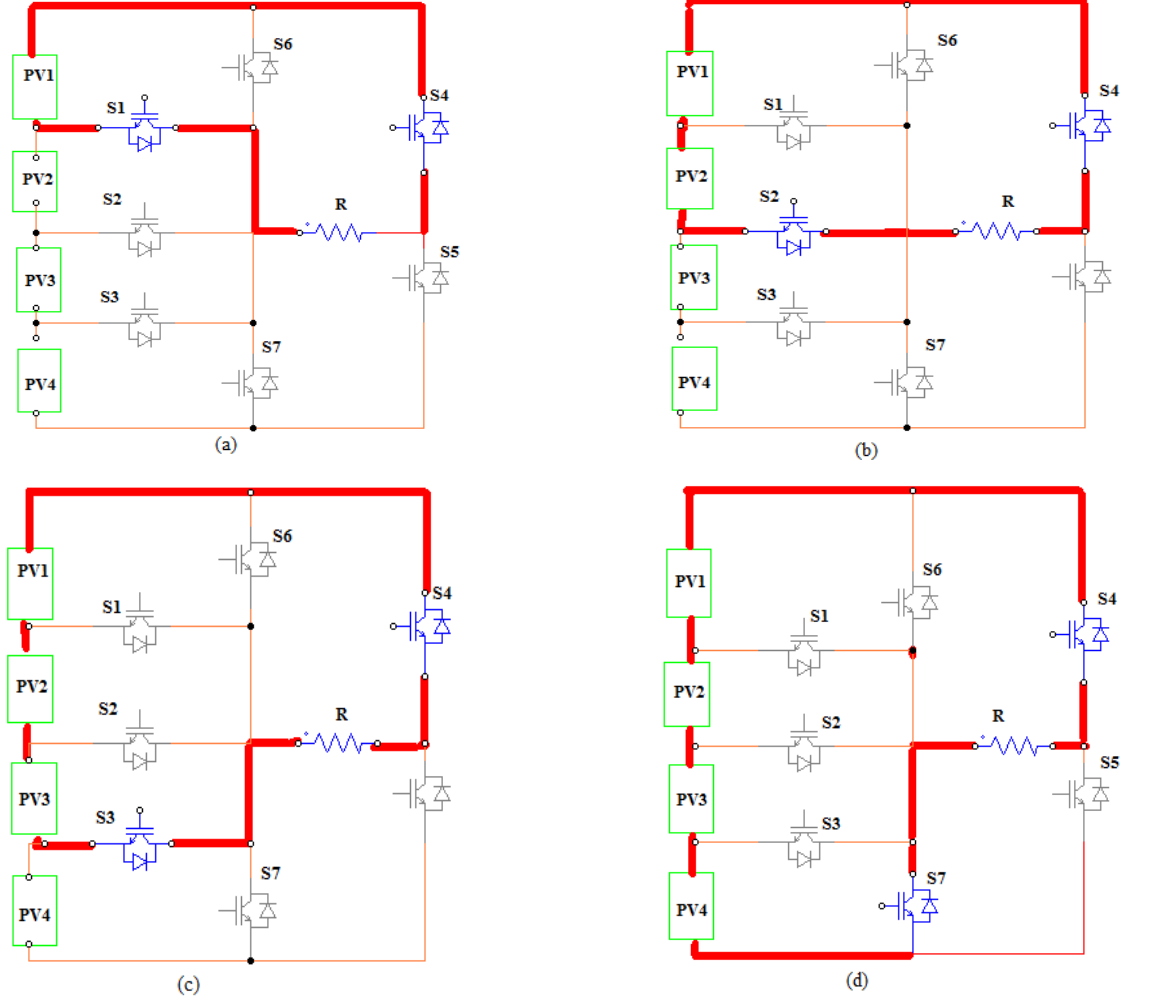
Figure 18 . Negative sequences for synthesizing the nine-level output voltage. ( a ) output voltage = − Vdc; ( b ) output voltage = − 2Vdc; ( c ) output voltage = − 3Vdc; ( d ) output voltage = − 4 Vdc.